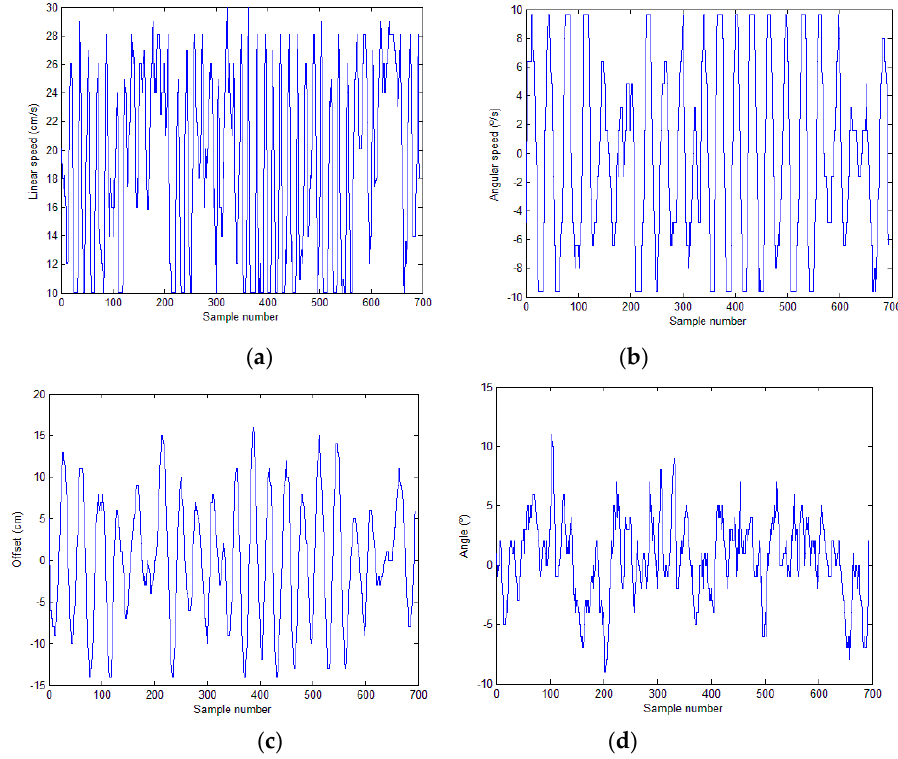
Table 6. Results obtained in a real field.